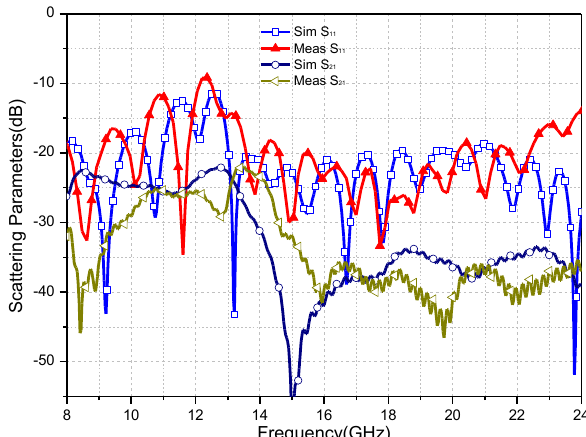
Figure 10. Photograph of the fabricated prototype.